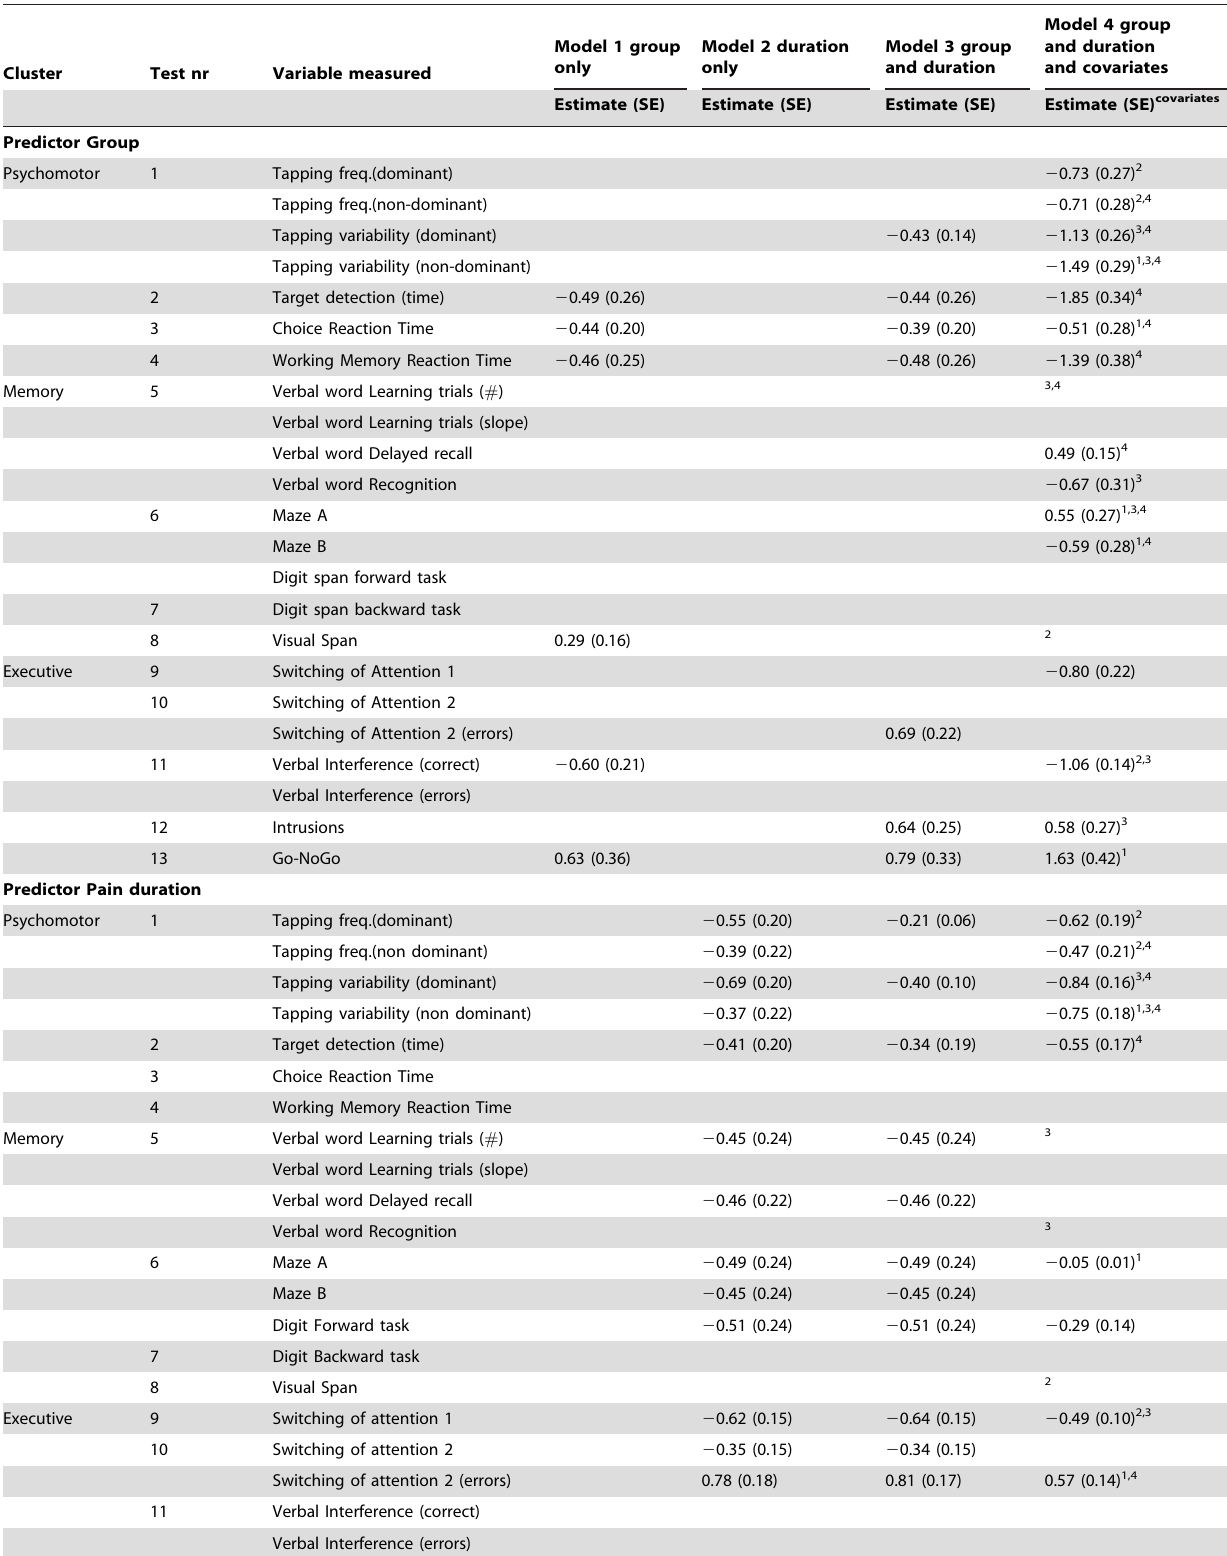
Table 4. Significant effects of the multivariate analysis.